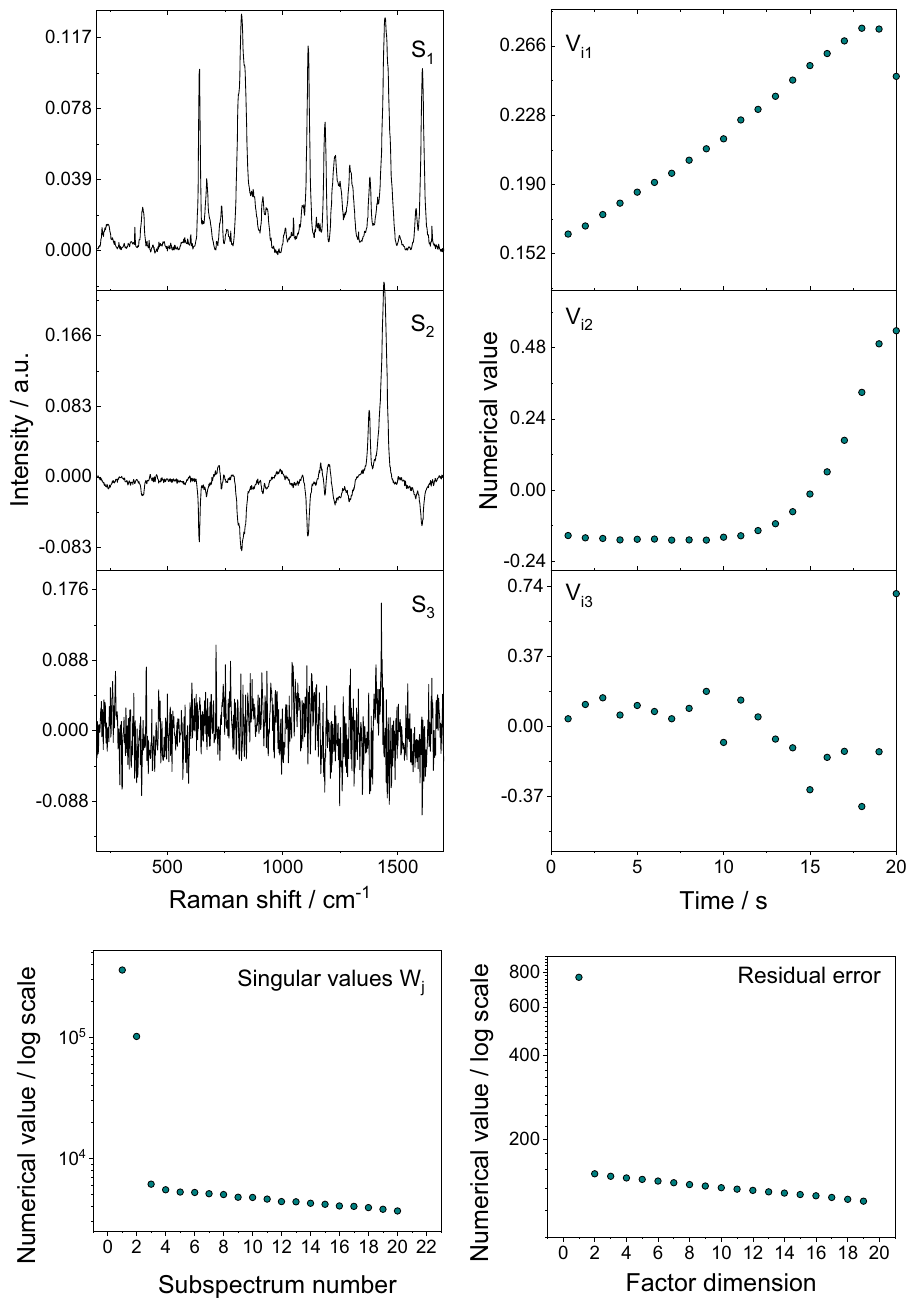
Figure 9. Multivariate analysis of Raman spectroscopy